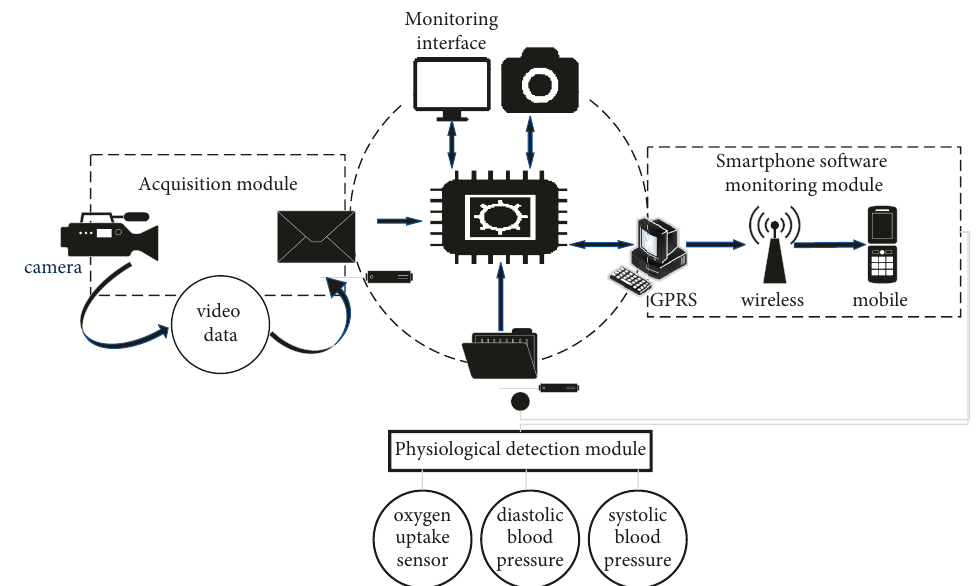
Figure 1: Framework diagram of intelligent health detection and collection.